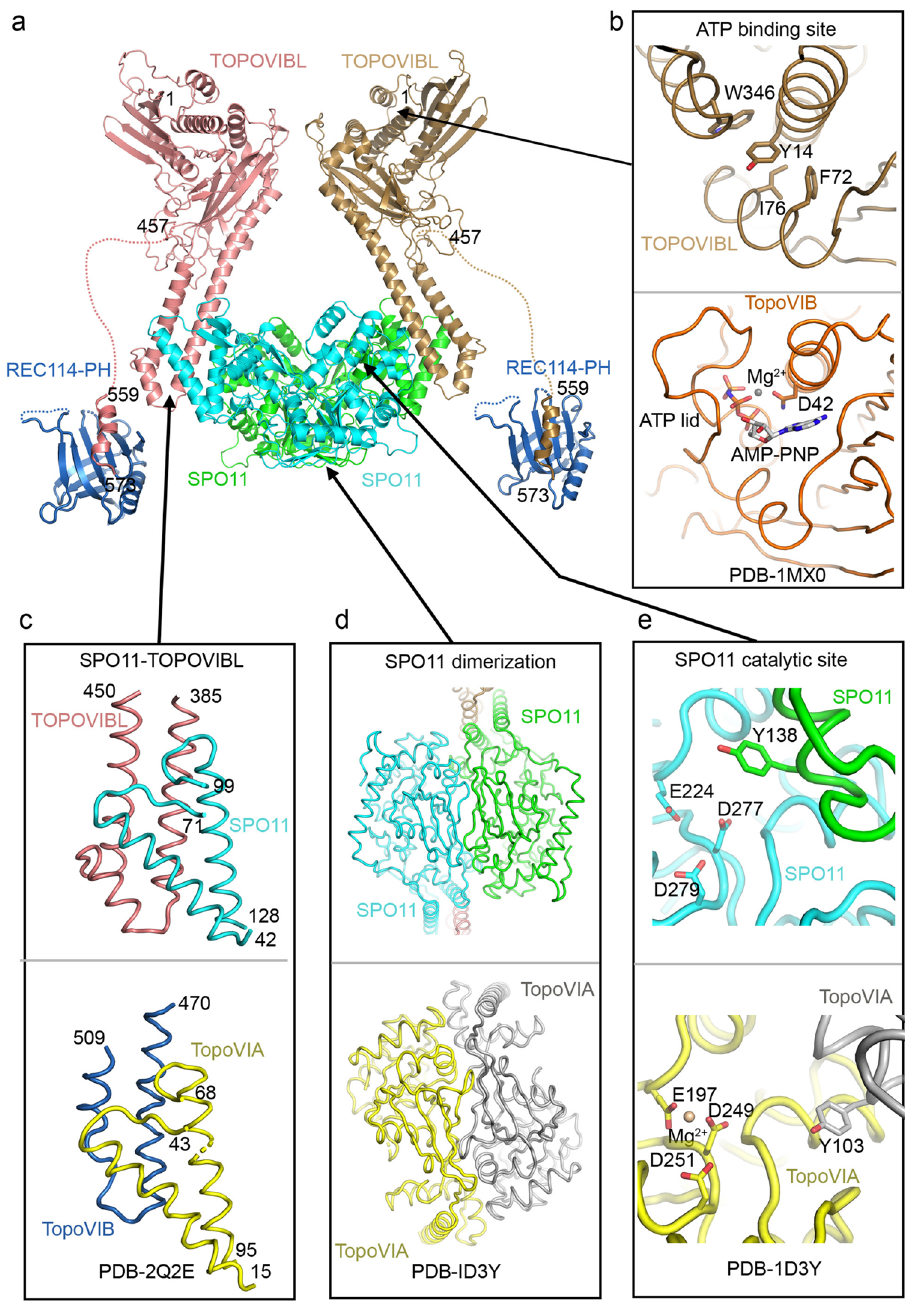
Fig. 8 | Model of the SPO11-TOPOVIBL-REC114 complex. a The structure of the complex of SPO11 and the C-terminal part of the TOPOVIBL transducer domain (residues 389-457) was modelled by AlphaFold2 29 . Full-length TOPOVIBL AlphaFold2-modelled structure (AF-J3QMY9) was then superimposed on the transducer domains of the SPO11-TOPOVIBL complex. Crystal structure of the REC114 PH domain bound the C-terminus of TOPOVIBLdetermined in thisstudy is shown linked to the SPO11-TOPOVIBL complex via a long-disordered linker. No contact between REC114 PH-TOPOVIBL C-ter and the SPO11-TOPOVIBL complex could be modelled. The modelled complex structure coloured according to the AlphaFold2 per-residue estimate of con fi dence (pLDDT) and predicted aligned error plots are shown in Supplementary Fig. 16. b The AlphaFold2 model (AF- J3QMY9) suggests that the putative ATP-binding site of TOPOVIBL is degenerated. Secondary structure elements forming the ATP-binding site in S. shibatae (PDB – 1MX0, lowerpanel), are predicted to be organiseddifferentlyinmouse TOPOVIBL.